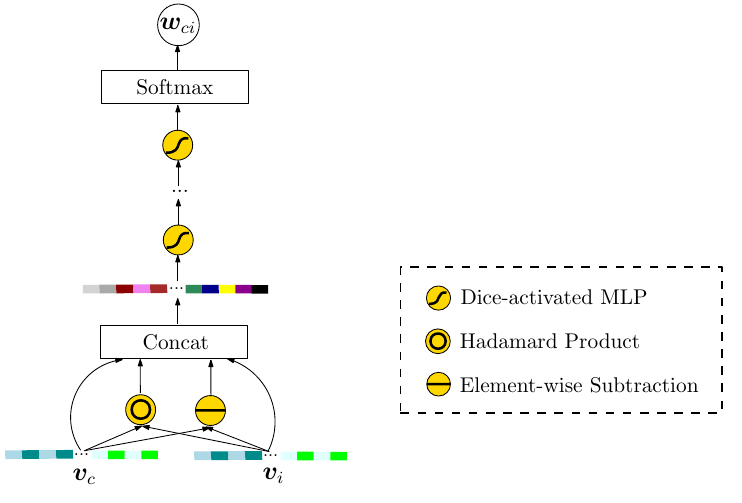
Figure 3. The working procedure of w ci